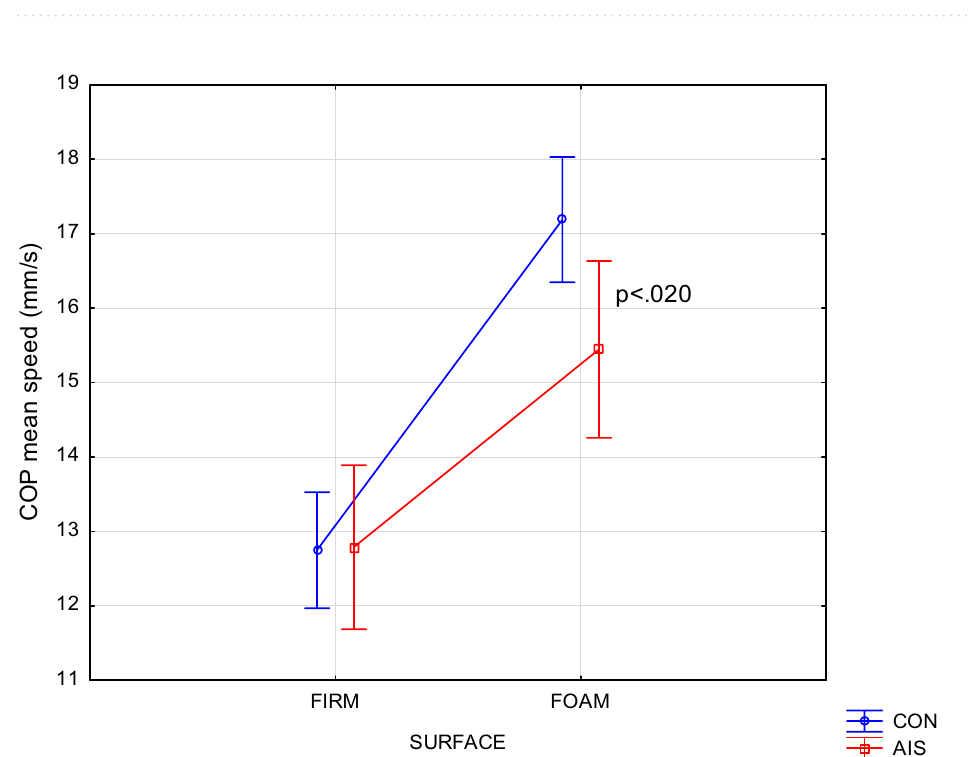
Figure 2. Group × Surface interaction (p = 0.0041) on COP mean speed in AP plane while standing with eyes